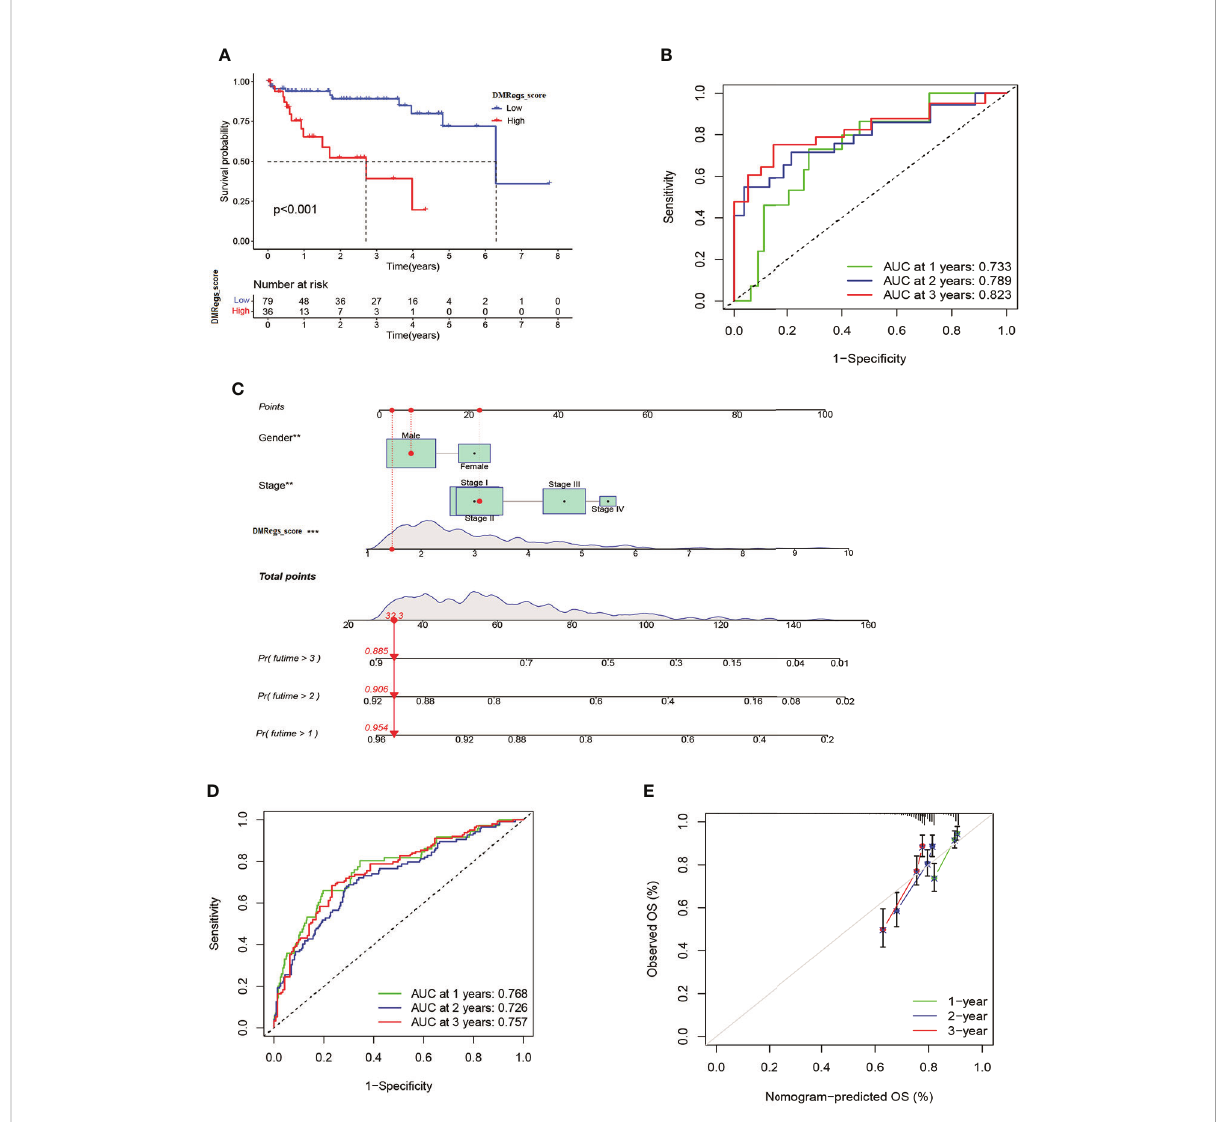
FIGURE 10 Validation of DMRegs_score in GSE76427 set and construction of nomogram. (A) The Kaplan- Meier curves of the OS between the two groups. (B) The predictive value of DMRegs_score was presented by ROC curves. (C) Nomogram to predict the 1-, 2- and 3-year OS of HCC patients in training set. (D, E) ROC and calibration curves of Nomogram for predicting of 1-, 2-, and 3-year OS in training set. ROC: receiver operating